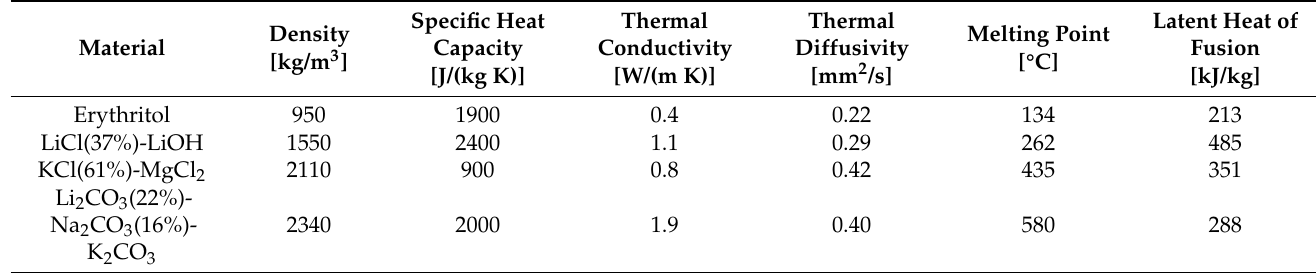
Table 2. Thermophysical properties of the studied PCMs with different melting points.